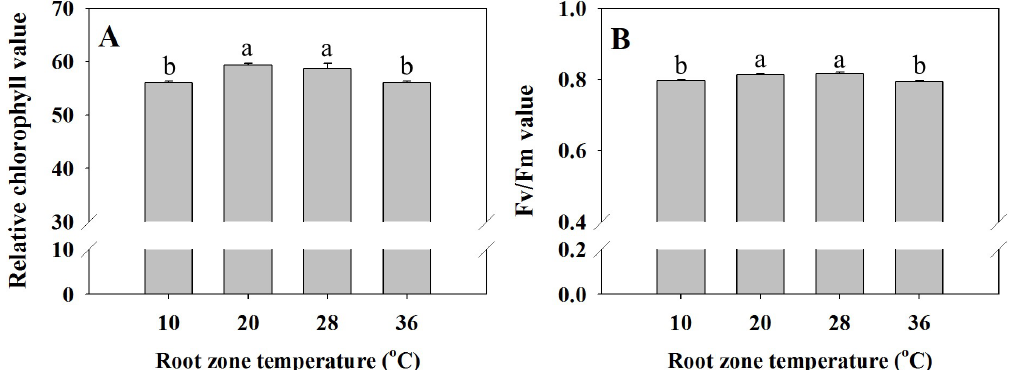
Figure 3. Relative chlorophyll value ( A ) and the ratio of variable to maximum fluorescence (F v /F m ) ( B ) of A. rugosa at four different root zone temperature (RZT) treatments (10, 20, 28, and 36 °C) at 32 days after transplant. Data are shown as the means ± standard error (SE) (relative chlorophyll value (n = 8) and Fv/Fm value (n = 3)). Different letters (a and b) show significant differences among the RZT treatments (Tukey’s test, p < 0.05).